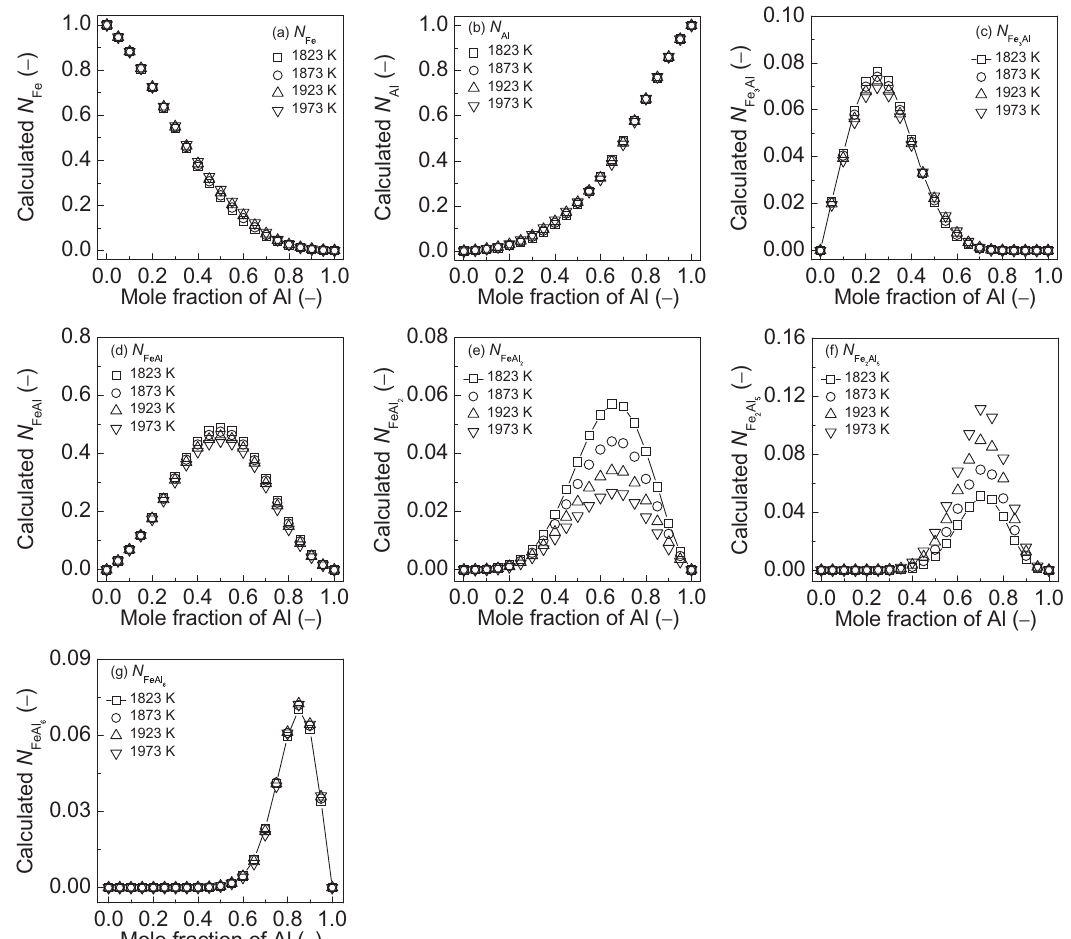
Figure 15: Relationship between mole fraction x Al of Al and calculated mass action concentrations N i of seven structural units as Fe (a), Al (b), Fe 3 Al (c), FeAl (d), FeAl 2 (e), Fe 2 Al 5 (f), and FeAl 6 (g) in full composition range of Fe – Al binary melts at four temperatures of 1823, 1873, 1923, and 1973 K (1550, 1600, 1650, and 1700°C),